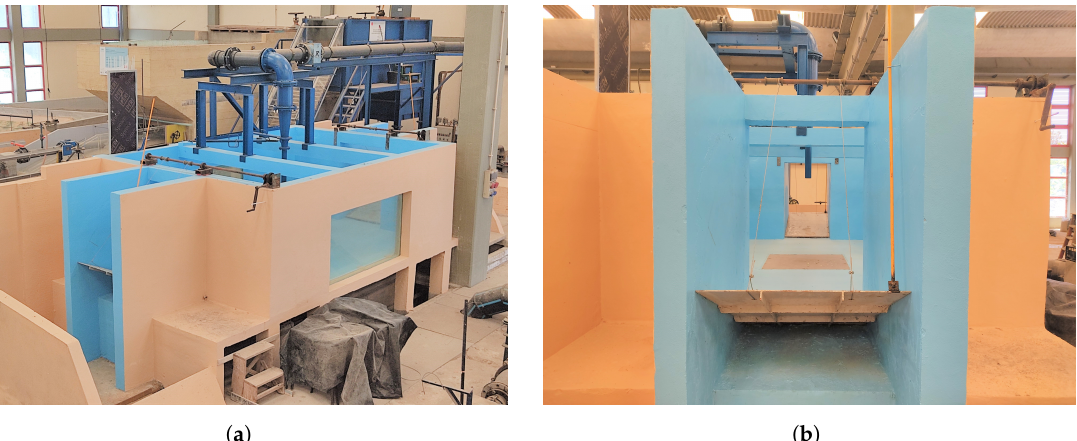
Figure 1. Photographs of the experimental facility at LNEC, Lisbon: ( a ) General view, ( b ) View from a flapgate.